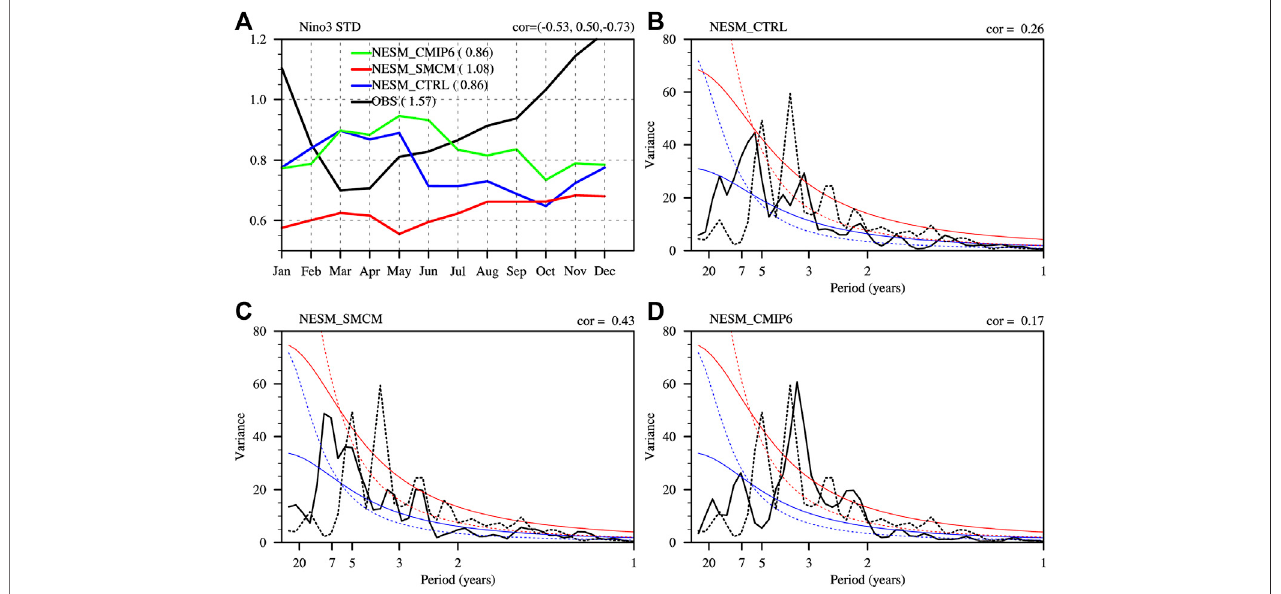
FIGURE 5 | (A) Monthly average standard deviation of the Niño-3 SST anomalies ( ° C). Power spectra of the Niño-3 SST anomalies in (B) NESM_CTRL, (C) NESM_SMCM, and (D) ENSM_CMIP6. The dashed lines in (B – D) represent the power spectra of the observations. The red and blue lines in (B – D) denote the 95% con fi dence level and red noise,